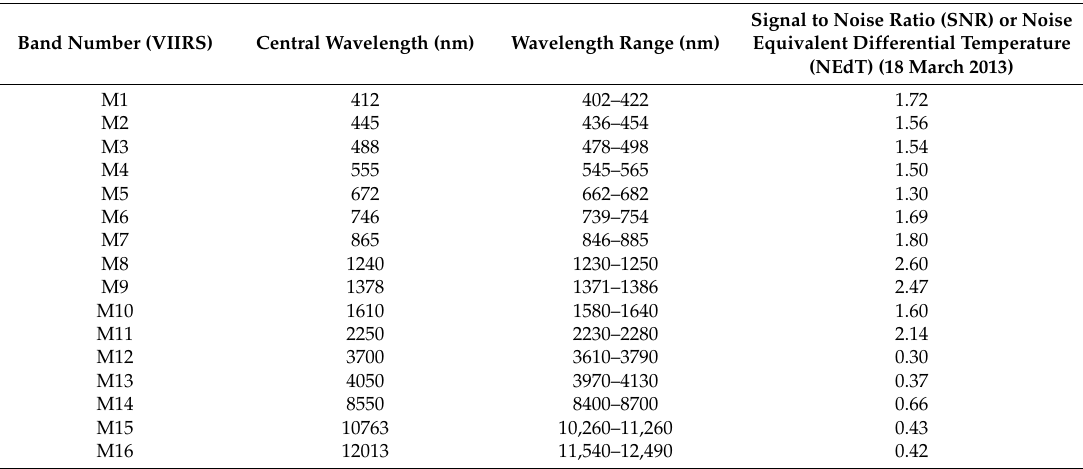
Table 1. Specification of sixteen moderate resolution bands of Visible Infrared Imaging Radiometer Suite (VIIRS) raw data records (RDR)